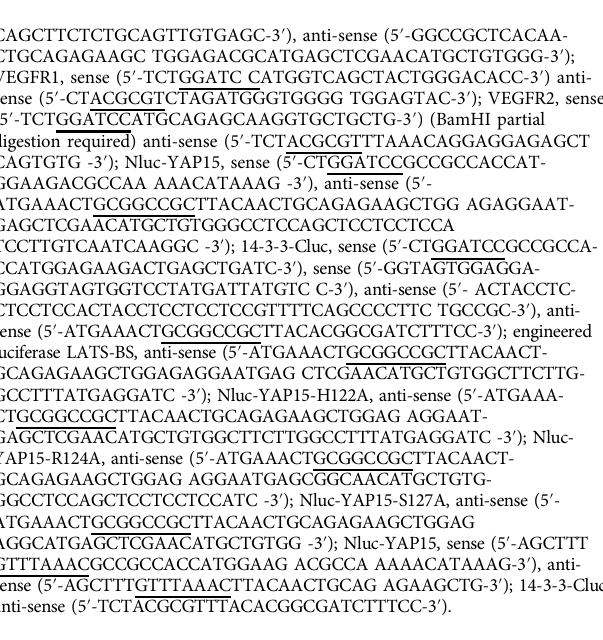
VEGFR was inhibited using 10 μ M axitinib for 3 h before VEGF treatment. All data are represented as mean ±